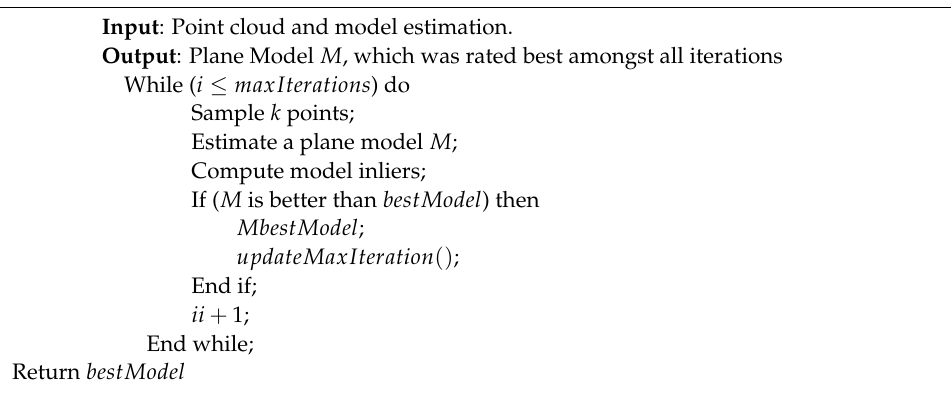
Algorithm 1 RANSAC algorithm to find plane model